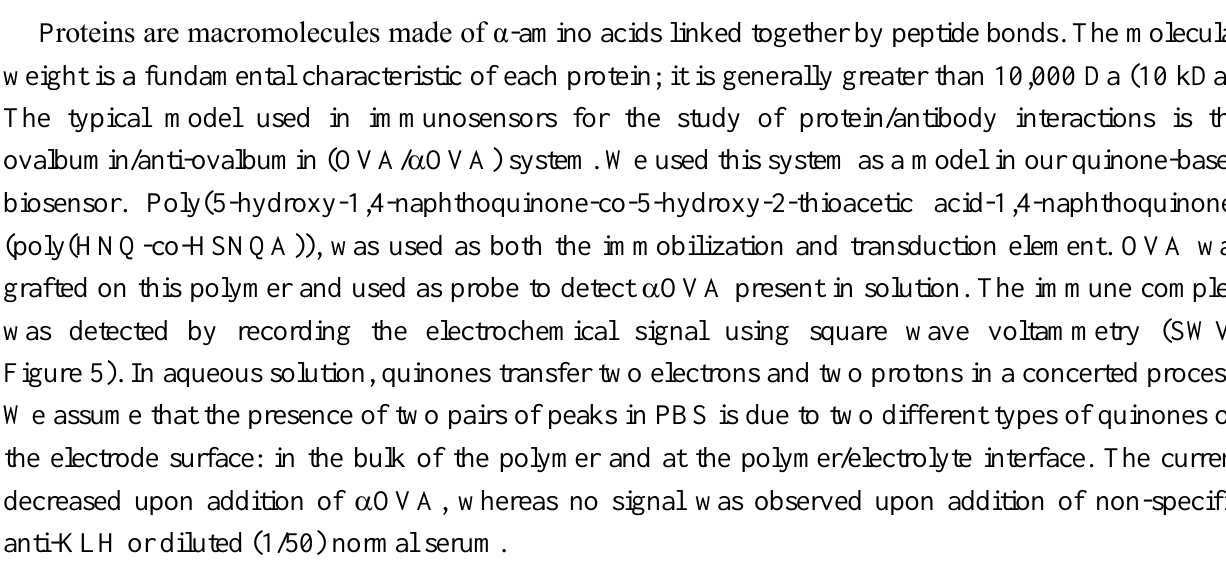
Figure 5. Square wave voltammetry (SWV) obtained for poly(HNQ-co-HSNQA)-modified electrodes before ovalbumin (OVA) grafting (solid line), after OVA grafting (dashed line) and after anti-ovalbumin (  OVA) complexation (dotted line). Serum dilution: 1/50